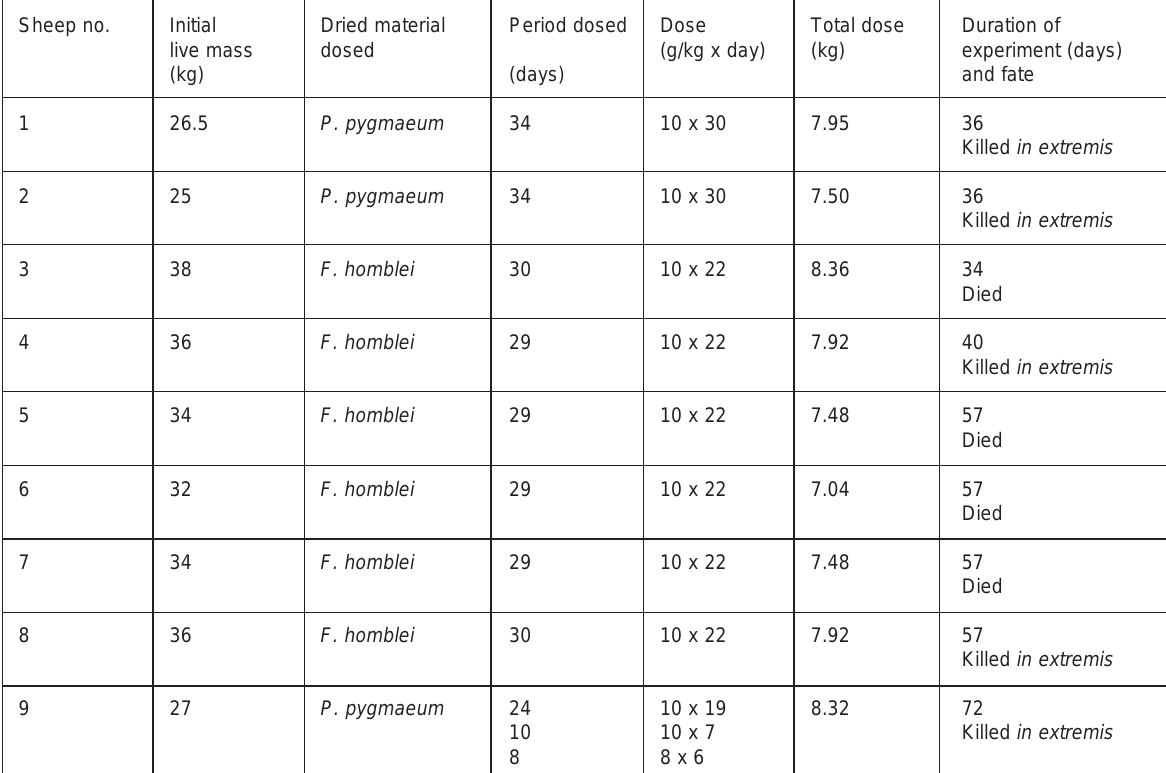
TABLE 2 Sheep examined in Series 2 after dosing with different gousiekte plants Sheep no.